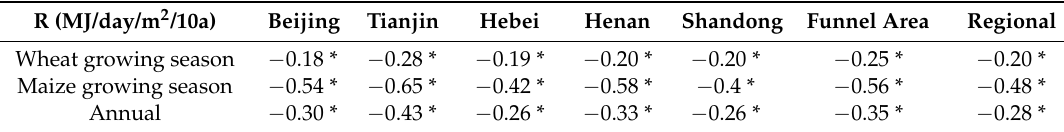
Table 4. The province-wide, funnel area, and regional statistics for the wheat, maize, and annual daily solar radiation average